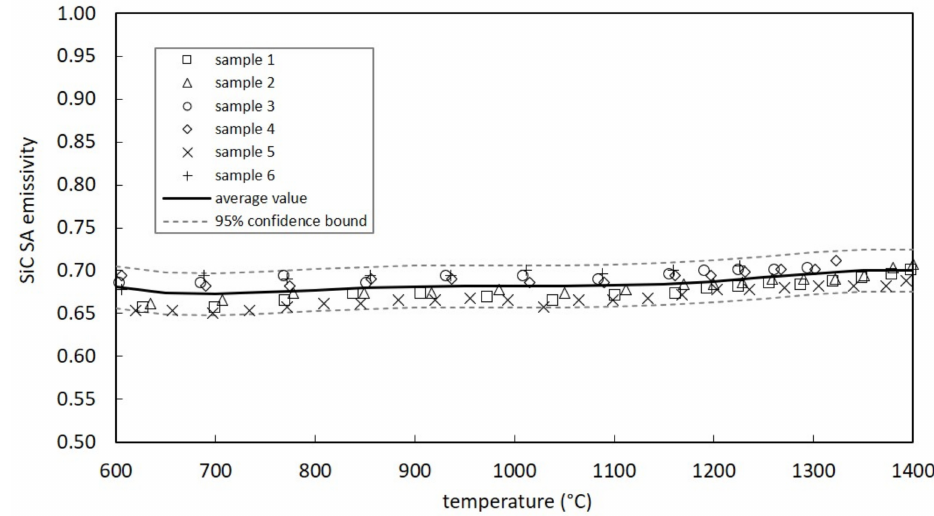
Figure 9. Measured emissivity values for SiC SA samples.